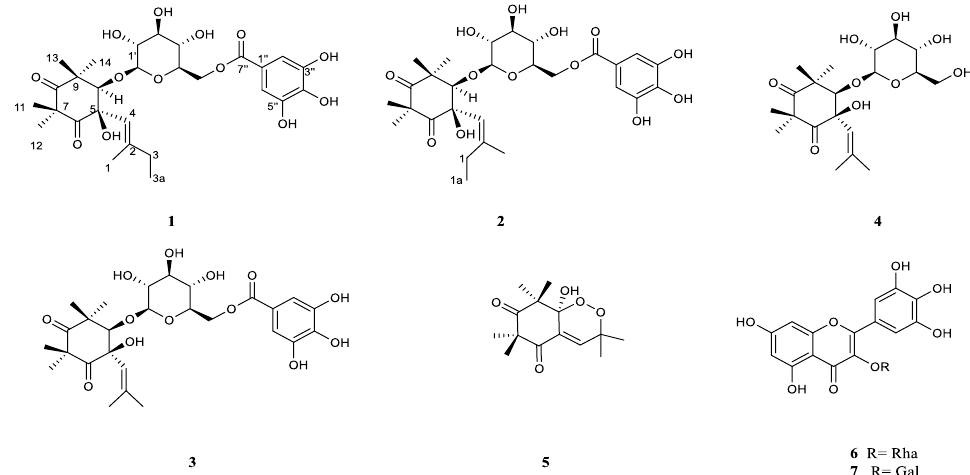
Figure 4. Chemical structure of compounds 1 – 7 , isolated from leaves of M. communis